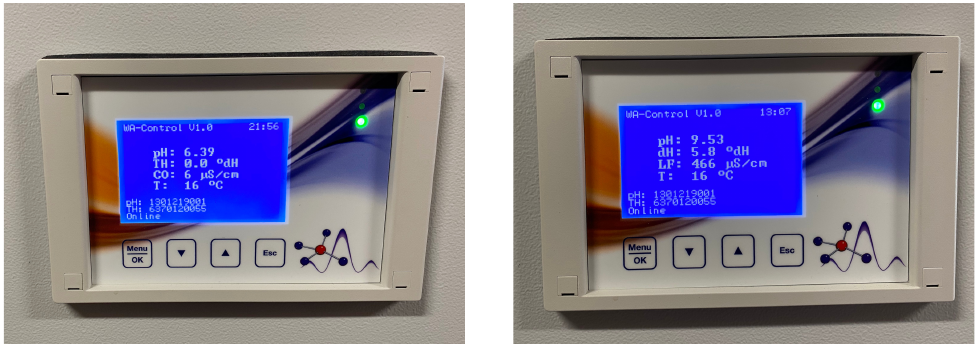
Figure 3. Measurement values of the WA-control. ( Left ): Reading values of the initial water (starting point for the production of the base model water) taken some minutes after filling the empty storage tank from the RISE in-house purified water supply; ( Right ): Typical reading values during the accelerated wear tests (values taken on 24 August